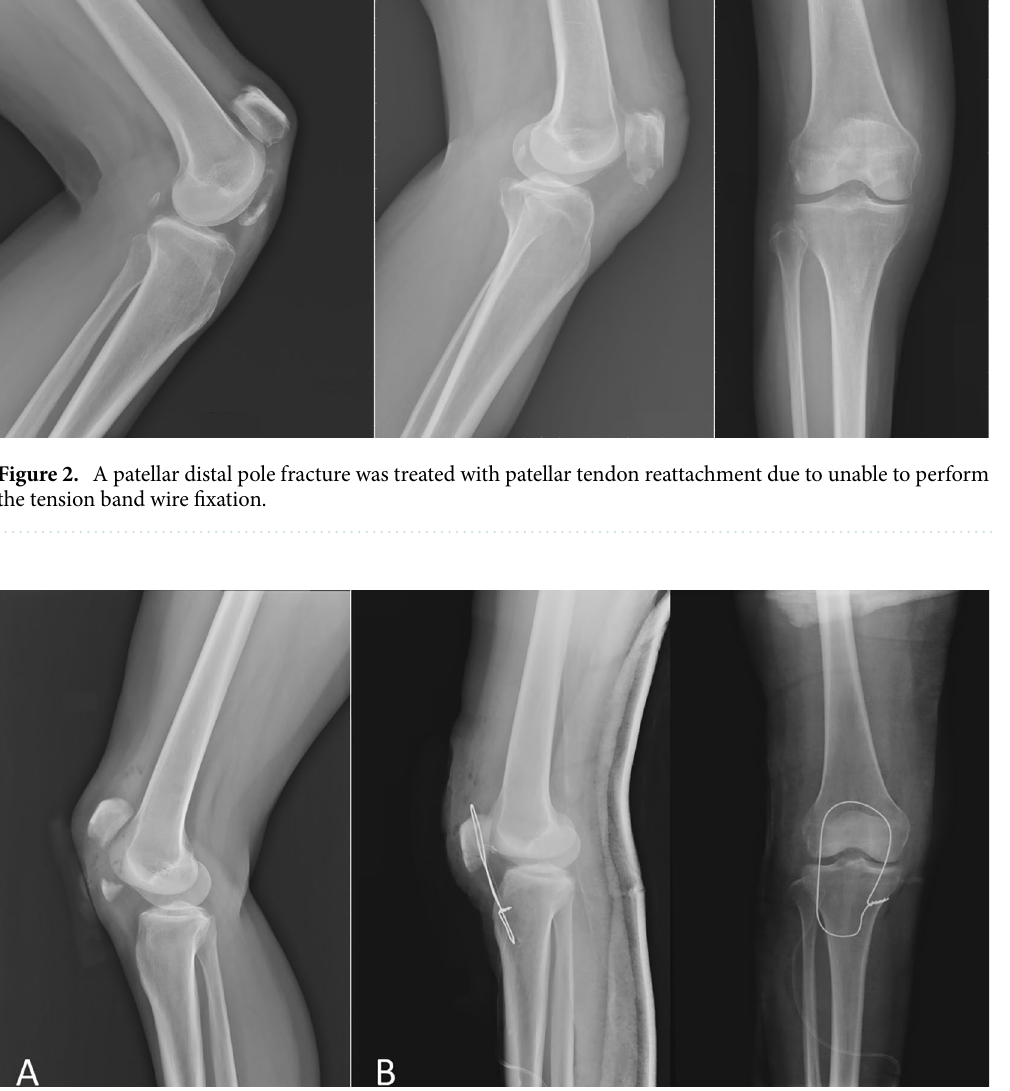
Figure 3. A patellar distal pole fracture was treated with patellar tendon reattachment, and the wire was passed transversely through both the tibial tuberosity and upper patella as a loop for